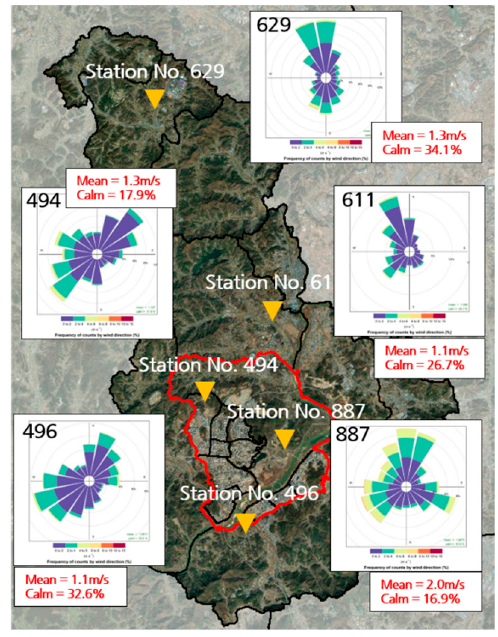
Figure 2. Wind rose map in study area.